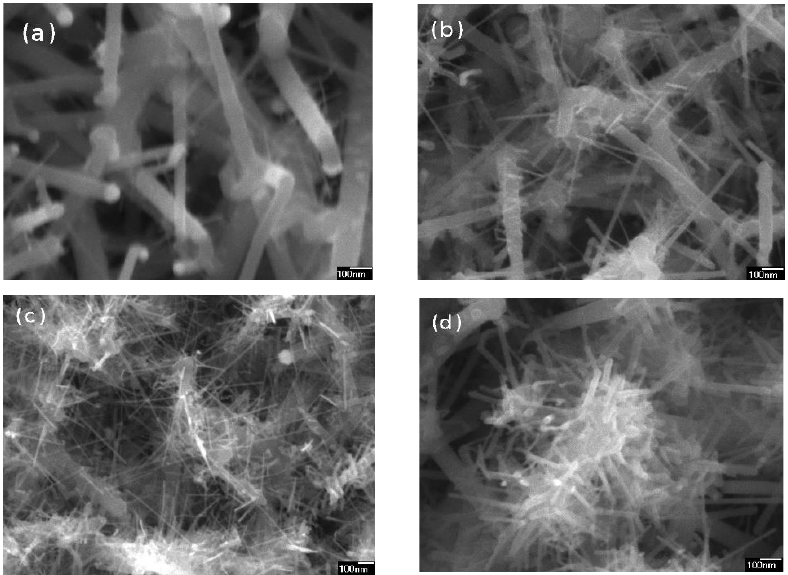
Figure 4. Branch density in correlation with cycle number: ( a ) one cycle, ( b ) two cycles, ( c ) three cycles and ( d ) four cycles.